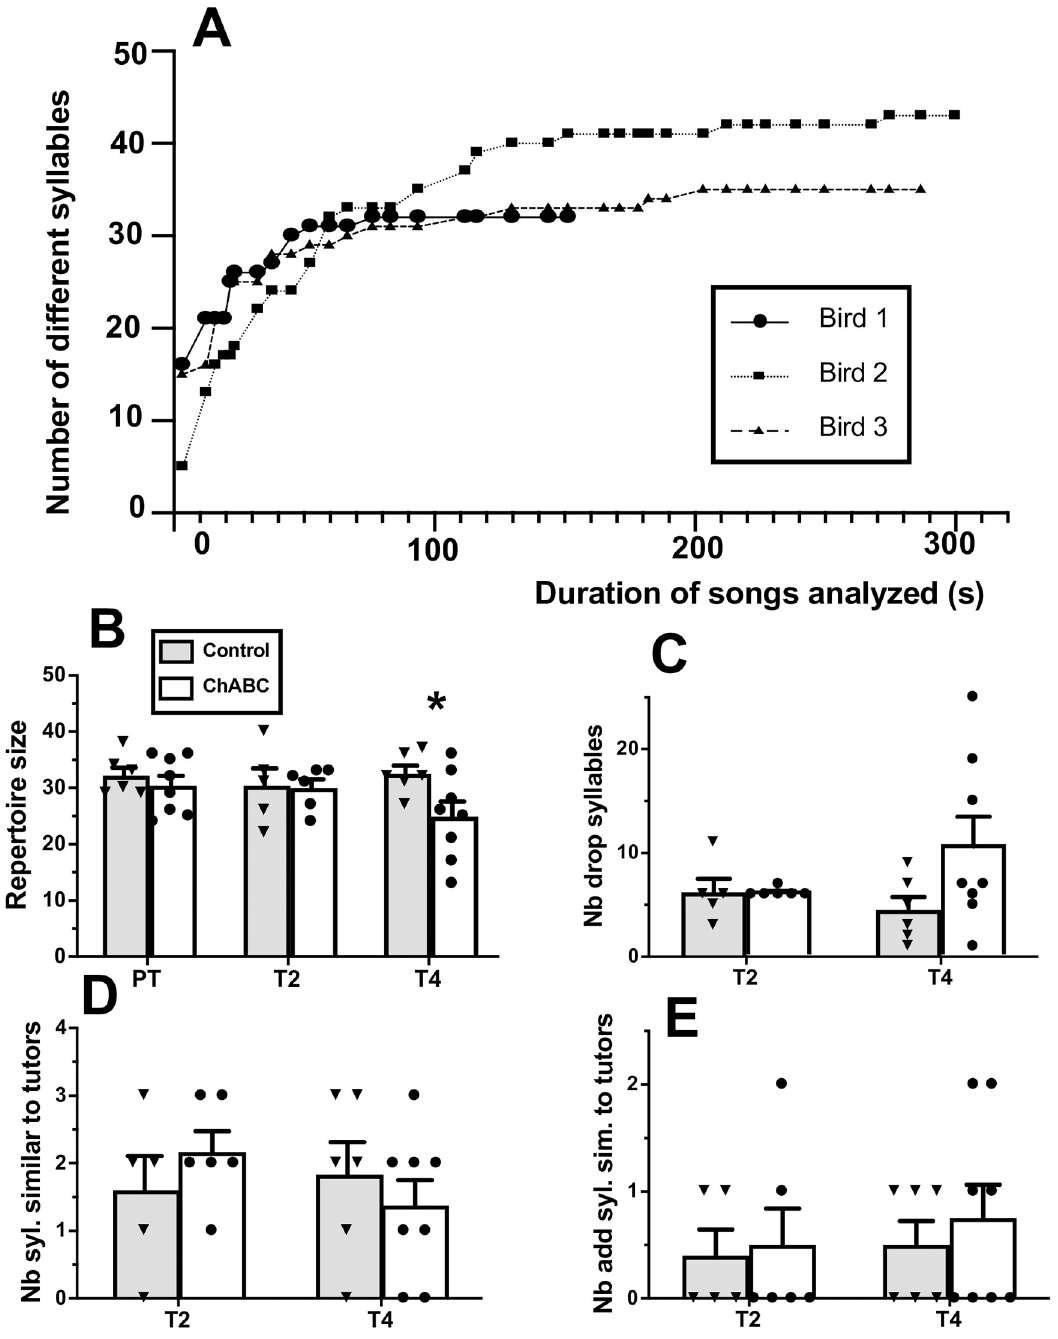
Fig 4. Effects of ChABC on repertoire size. A. Cumulative number of new syllables identified in the songs of three randomly selected male canaries as a function of the total duration of songs analyzed. B: repertoire size in the control and ChABC-treated males before (PT) and 2 or 4 weeks after surgery (T2, T4). C: Number of syllables dropped at T2 or T4 as compared to the repertoire during the PT. D: number of syllables similar to a tutor syllable and E: number of added syllables that were similar to a tutor syllable at T2 and T4. � = p < 0.05 for the comparison with the control group by t-test.